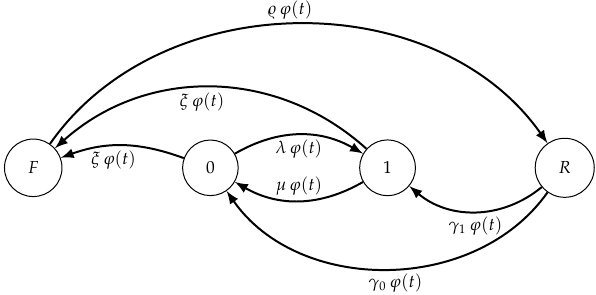
Figure 7. The state diagram of the Markov chain N ( t ) with (cid:96) =